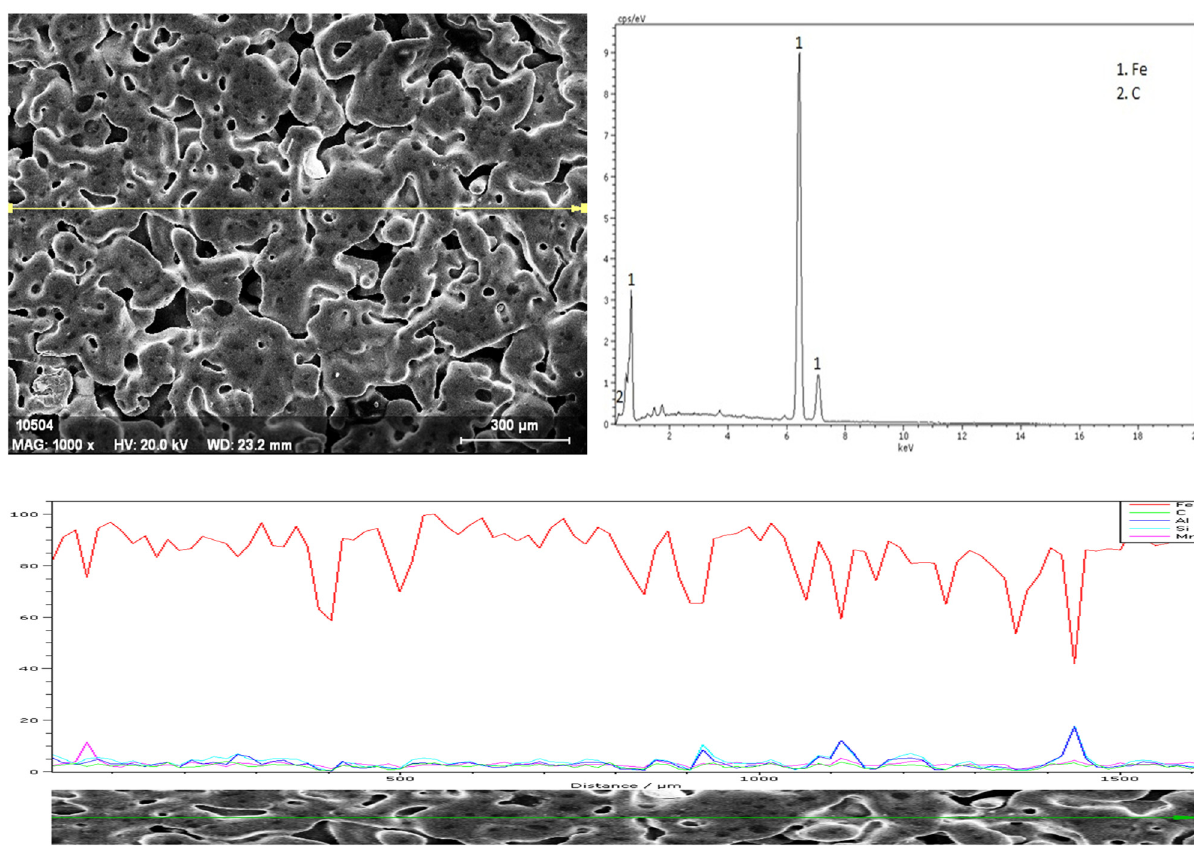
Figure 8: EDX analysis of 98.33% Fe – 1.66% B 4 C composite.